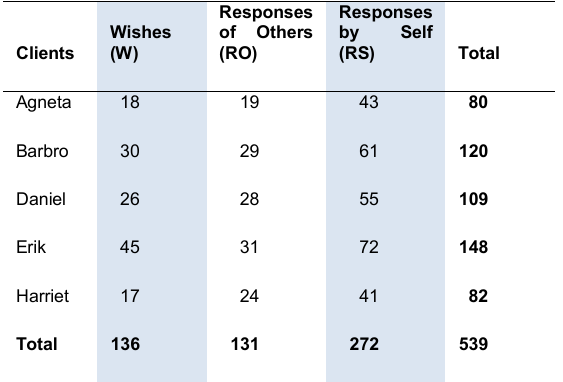
Table 2: Numbers of CCRT standard categories of the 3 components W, RO and RS for each client.